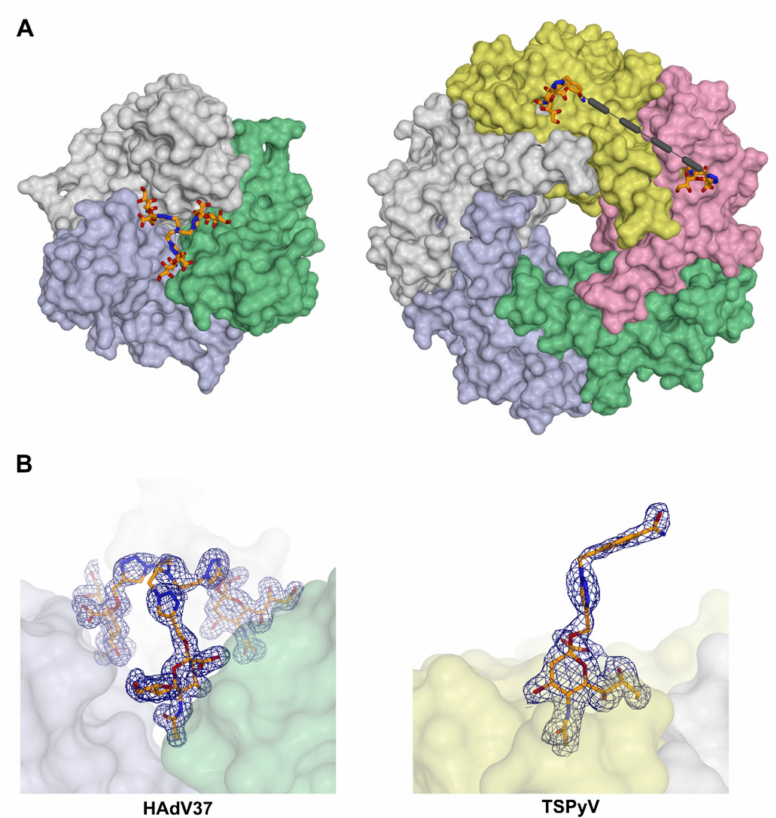
Figure 5. Sialic acid based anti-viral compounds. ( A ) Structure of the HAd37 fiber knob in a complex with a trivalent sca ff old functionalized with sialic acid ( left ) and the structure of the Trichodysplasia spinulosa -associated Polyomavirus (TSPyV) VP1 pentamer in a complex with a divalent sialic acid-presenting compound ( right ). For simplification, the compound is only depicted in two of the five binding sites of the TSPyV VP1, although it is present in the other three, as well. Absent parts of the ligand backbone structure are represented with dashed lines. ( B ) Corresponding electron densities for the ligands shown above. Proteins are depicted as surfaces with distinctly colored single protomers and organic compounds in stick representation, respectively. The electron density 2Fo-Fc maps are represented as blue meshes and displayed at a level of 1 σ (standard deviation of the mean) and a radius of 1.6 Å around the respective ligand. PDB IDs 4xqa (adenovirus 37) and 6hkv